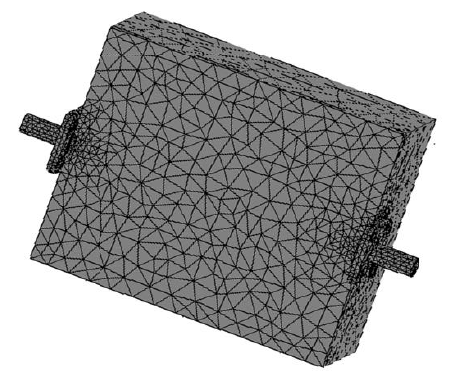
Figure 3. Mesh of microstrip for FEM simulation.